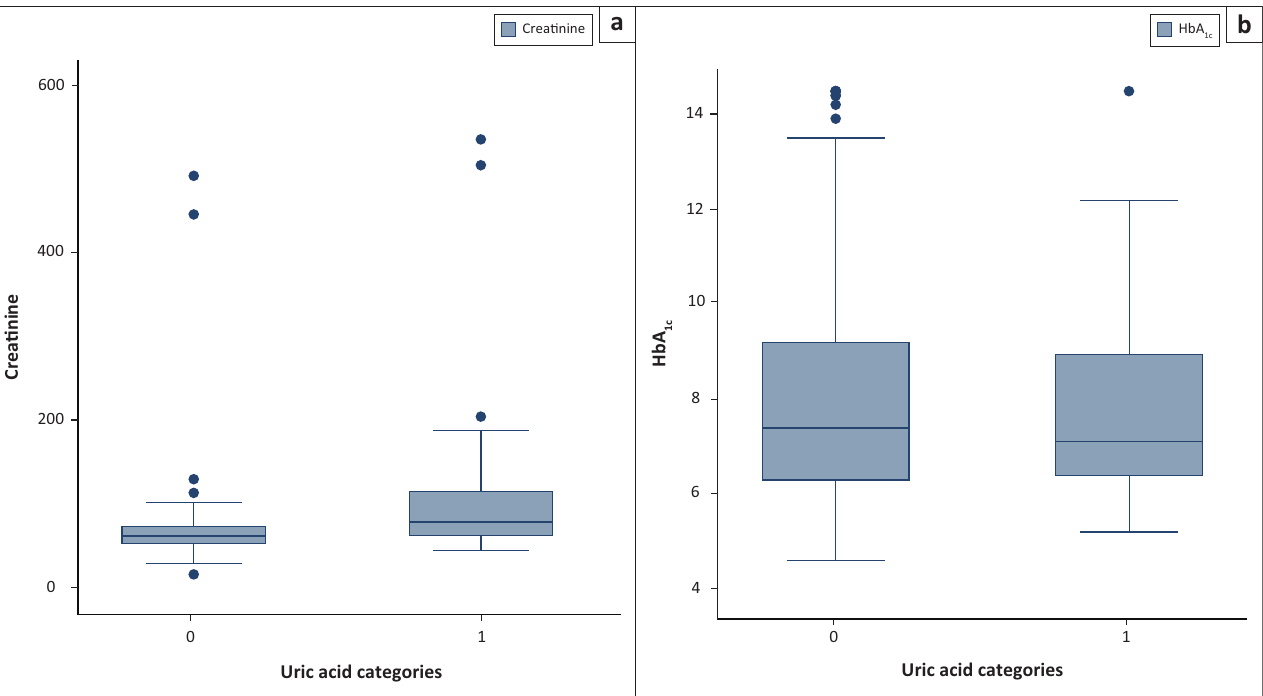
FIGURE 1: Comparison of (a) serum creatinine concentration and (b) glycated haemoglobin (HbA receiving treatment in Gaborone, Botswana, September–December